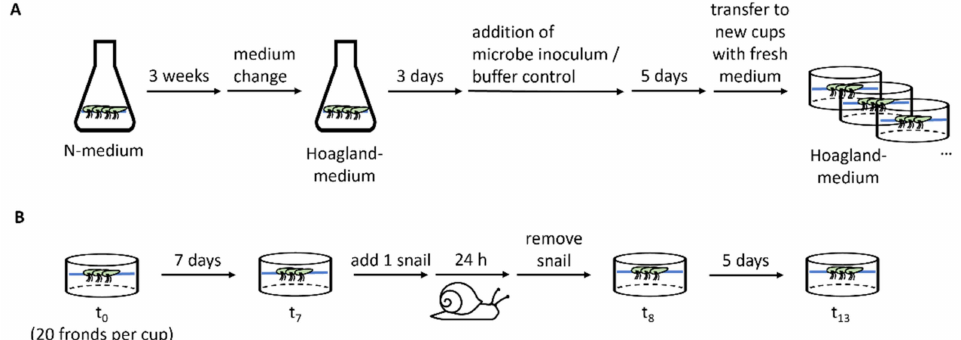
Figure 2. Overview of the experimental procedure. ( A ) Scheme of the plant pre-treatment, including plant propagation on N-medium, adaptation to Hoagland medium, microbe inoculation, and incuba- tion before the plants were divided to the cups for conducting the experiment. For each genotype, one Erlenmeyer flask was used per treatment. ( B ) Experimental procedure to determine the plant growth before (t 0 –t 7 ) and after herbivory attack (t 8 –t 13 ) as well as the herbivore damage within 24